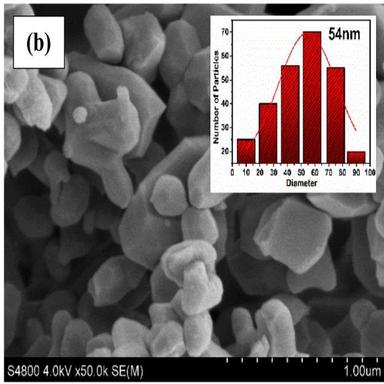
(a-d, a′-d′): SEM images, and histograms of Mg1-xCoxFe2O4 with (x = 0, 0.03, 0.06, and 0.09) nanoparticles and (a′-d′) EDX spectra of Mg1-xCoxFe2O4 with (x = 0, 0.03, 0.06, and 0.09) nanoparticles.